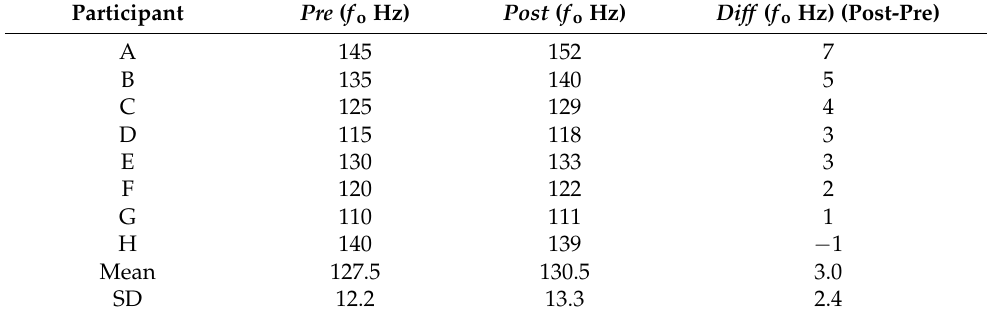
Table 1. Example 1. Each individual’s average fundamental frequency (in Hz) before ( pre ) and after ( post ) treatment. The right-most column is the post minus pre difference in Hz. Further illustrated are the mean and standard deviation for each column. Because the inter-individual variation in the difference scores is so small and most participants have a small, positive effect, a t -test applied to the mean difference is statistically significant. t 7 = 3.5, p = 0.01. The standardized mean difference, Cohen’s d , is